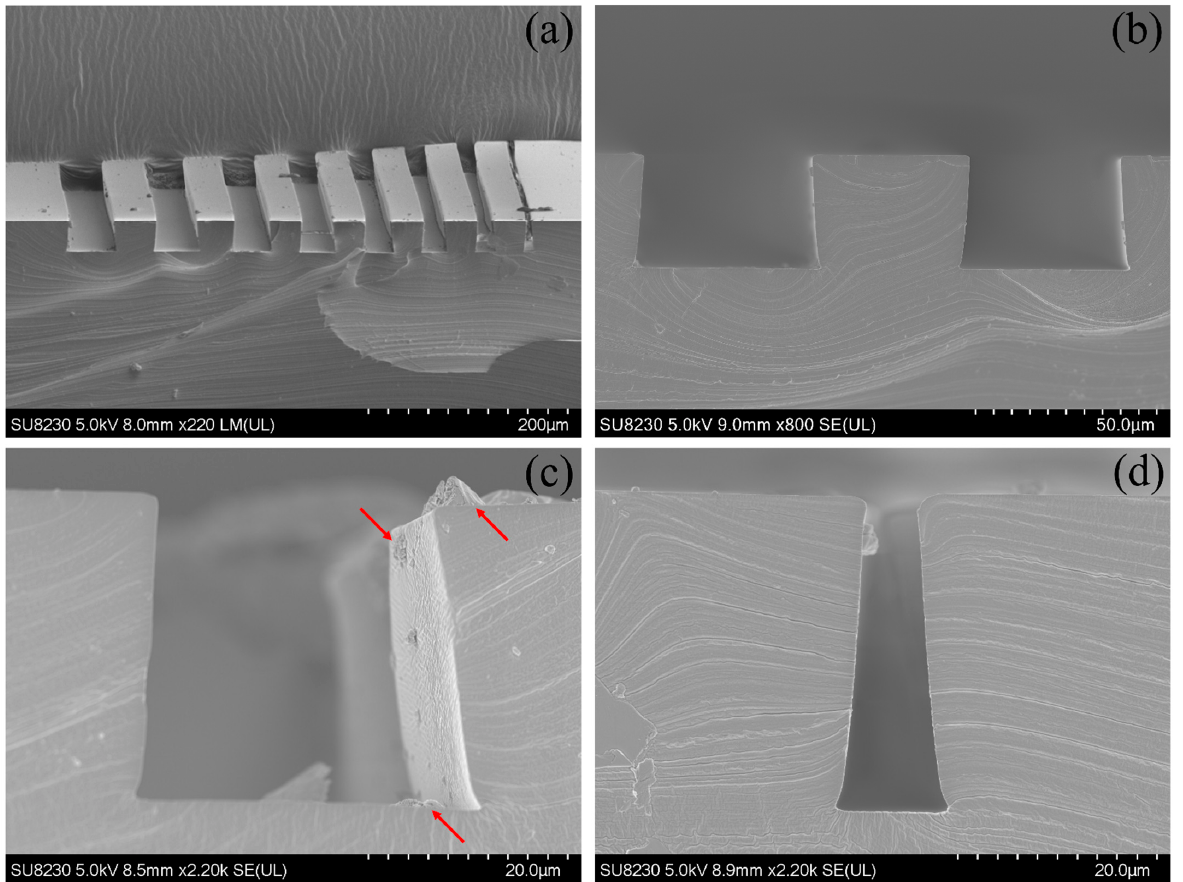
Figure 4. Images of a 30-µm-high PDMS structure with the microchannels with the widths of 10, 20, 25, 30, 35, 40, 45, and 50 µm taken with a Hitachi SU-8230 SEM. Cross-sections of: ( a ) the entire structure (with all channels visible), ( b ) 50-µm- and 45-µm-wide channels, ( c ) 35-µm (red arrows indicate examples of possible airborne contamination), and ( d ) 10-µm-wide channels, respectively. The top of the channels is narrower compared to the bottom by about 5 µm.